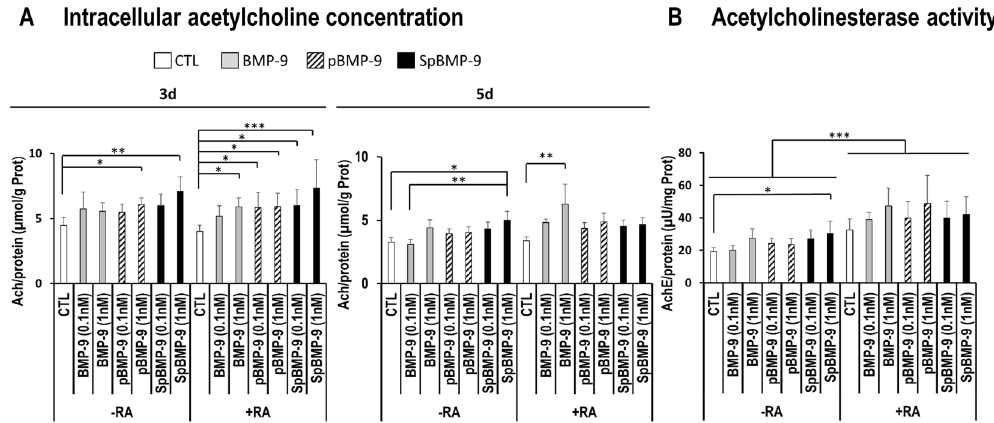
Figure 7. Effect of pBMP-9 and SpBMP-9 on the intracellular Ach and AchE. ( A ) Intracellular Ach in SH-SY5Y cells stimulated with 0, 0.1 or 1 nM BMP-9, pBMP-9 and SpBMP-9 + / − 10 μ M RA for 3d and 5d ( B) AchE activity for SH-SY5Y cells stimulated with 0, 0.1 or 1 nM BMP-9, pBMP-9 and SpBMP-9 + / − 10 μ M RA for 5d. Results are the means ± SEM of at least 4 independent experiments ( * p < 0.05, ** p < 0.01, *** p <